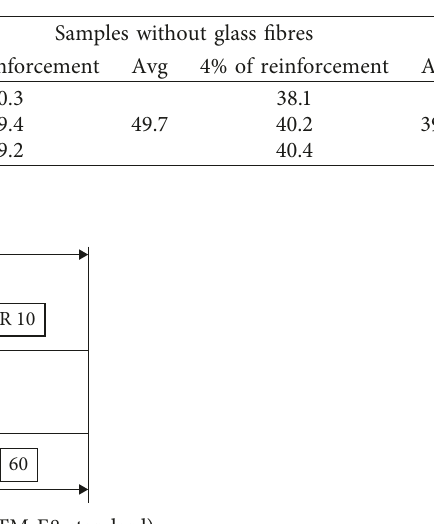
Table 4: Hardness test.